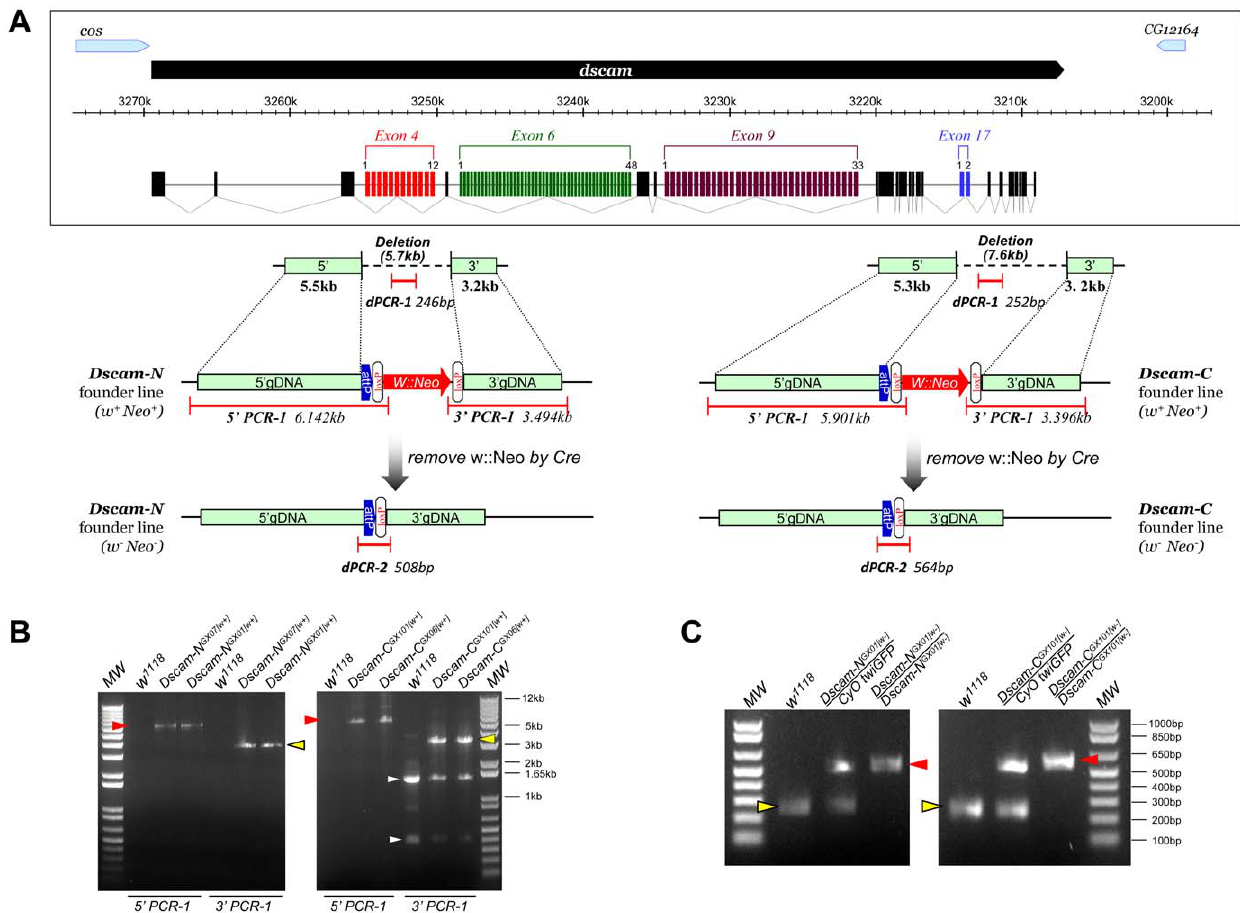
Figure 3. Gene targeting of Dscam-N and Dscam-C . A . Targeting design and PCR verification of Dscam-N and Dscam-C founder lines. Boxed are the genomic DNA (gDNA) structure and alternative-splicing patterns of Dscam locus. Dscam locus contains four alternative-splicing exons: 4, 6, 9 and 17 [13]. Green boxes are gDNA regions used for 5 9 and 3 9 homology arms in the targeting constructs. In the Dscam-N founder knock-out line, a 5.7 kb genomic DNA covering the alternatively spliced exon 4 are deleted. In the Dscam-C founder knock-out line, a 7.6 kb genomic DNA covering the alternatively spliced exon 17 plus all the remaining downstream exons and 3 9 UTR are deleted. Dscam-N and Dscam-C founder knock-out lines carrying W::Neo marker are verified by 5 9 and 3 9 PCRs. 5 9 or 3 9 PCR is designed with one primer annealing within the W::Neo, while another primer anneals outside the gDNA region used for homology arms (‘‘5 9 gDNA’’ or ‘‘3 9 gDNA’’) in targeting constructs. Thus, only the correct targeting events will yield PCR products of expected size. Dscam-N and Dscam-C founder lines with W::Neo removed are further verified by dPCR-1 and dPCR-2. dPCR-1 is located within, while dPCR-2 spans over, the deleted region of Dscam-N or Dscam-C . B . 5 9 and 3 9 PCR-1 (red and yellow arrowheads, respectively) results from adults of Dscam-N GX07[w + ] /CyO, Dscam-N GX01[w + ] /CyO, Dscam-C GX101[w + ] /CyO and Dscam-C GX06[w + ] /CyO . w 1118 was used as wild type control. White arrowheads pointing to non-specific PCR products. C . dPCR-1 (yellow arrowhead) and dPCR-2 (red arrowhead) results from embryos of Dscam- N GX01[w 2 ] and Dscam-C GX101[w 2 ] with W::Neo removed. Dscam-N GX01[w 2 ] and Dscam-C GX101[w 2 ] were balanced on CyO, twi-GAL4, UAS-2xEGFP (‘‘CyO twiGFP’’) chromosome so homozygous embryos could be distinguished by the absence of GFP. w 1118 was used as the wild type control. For each PCR reaction genomic DNA was prepared by pooling approximately ten embryos together. For each sample, dPCR-1 and dPCR-2 reactions were carried out separately and were pooled before loading on the gel. MW: 1kb-plus DNA ladder (from Invitrogen); 5 9 and 3 9 : the 5 9 and 3 9 homology arms of Dscam-N and Dscam-C targeting construct. CyO (BL # 5626); w 1118 ; In(2LR)Gla, wg Gla-1 /CyO, P{GAL4-